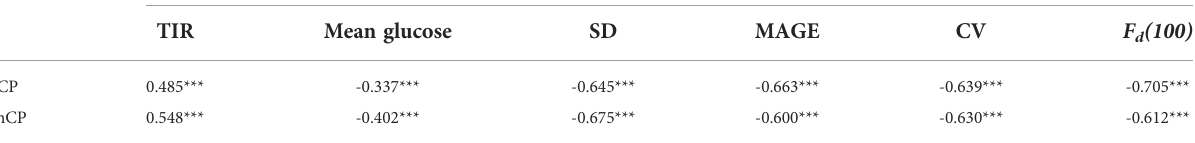
Values represent Spearman correlation coef fi cients. FCP, fasting C-peptide; 2hCP, 2-hour postprandial C-peptide; TIR, time in range; SD, standard deviation of glucose; MAGE, mean amplitude of glucose excursions; CV, coef fi cient of variation. ***P < 0.001.